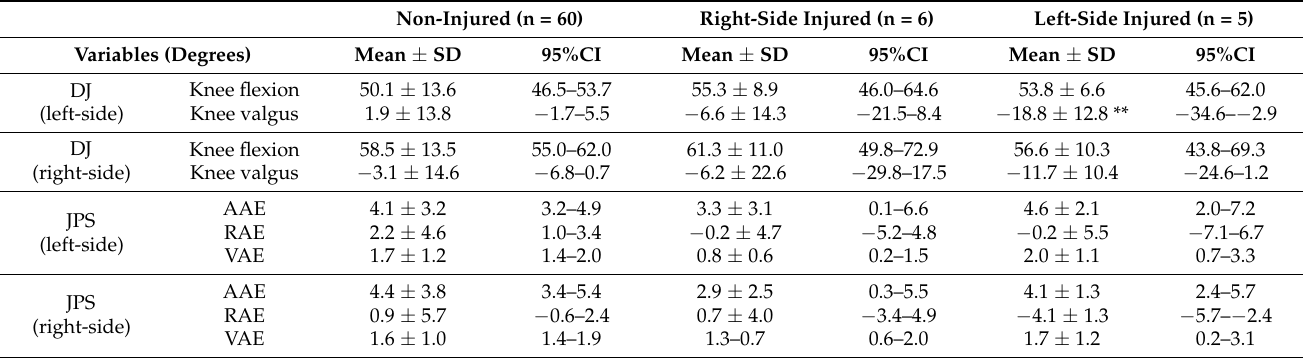
Table 2. Descriptive data for the drop jump and proprioception